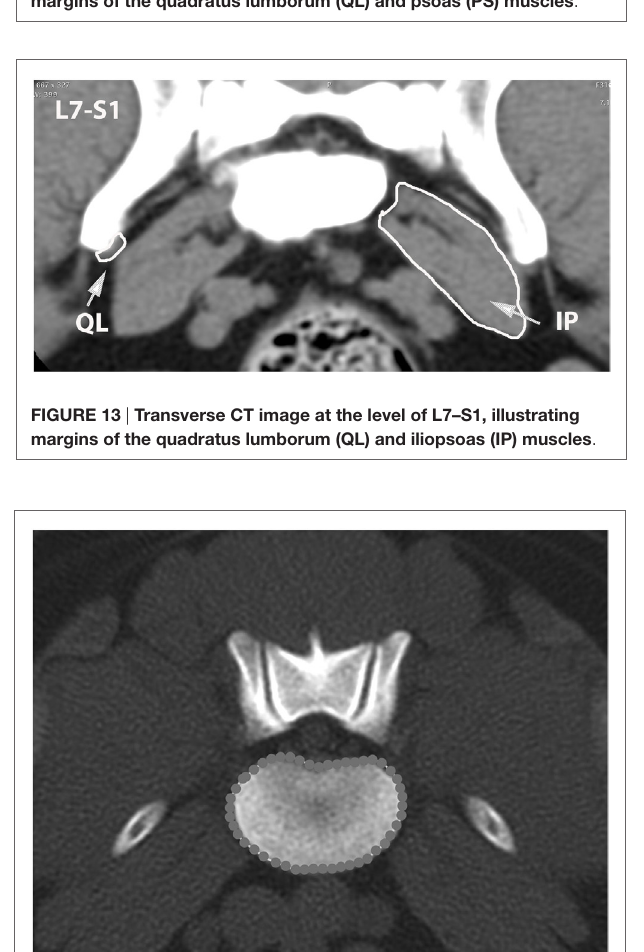
FIGURe 12 | transverse Ct image at the level of L6–7, illustrating margins of the quadratus lumborum (QL) and psoas (Ps) muscles .